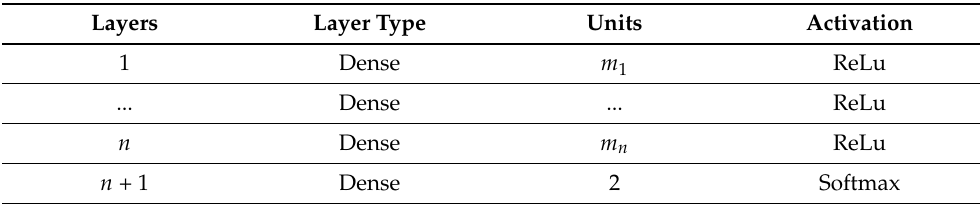
Table 1. Multilayer perceptron (MLP) parameters when modeling interconnected Physical Unclon- able Function network (IPN). n is the depth of the network and m i is the total number of Physical Unclonable Function (PUF) segments on the i -th